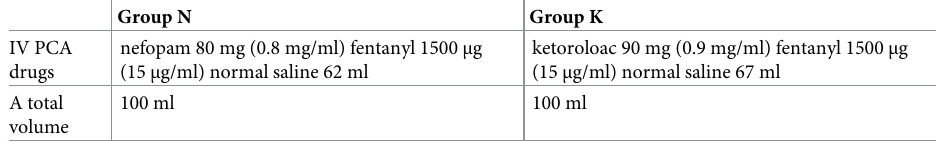
Table 1. The regimen of intravenous patient-controlled